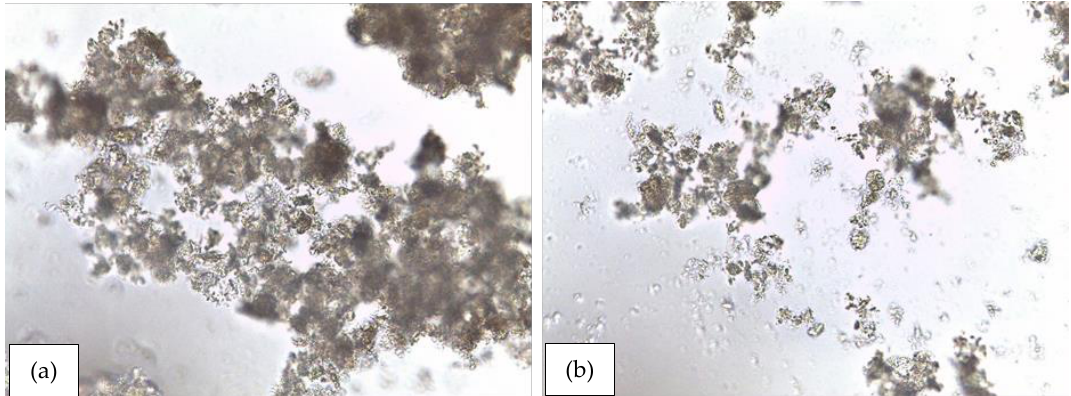
Figure 7. The flocs/sludge produced under 40× Magnification when ( a ) red lentil extract, ( b ) alum Figure 7. The flocs / sludge produced under 40 × Magnification when ( a ) red lentil extract, ( b ) alum used used as coagulant. as coagulant.